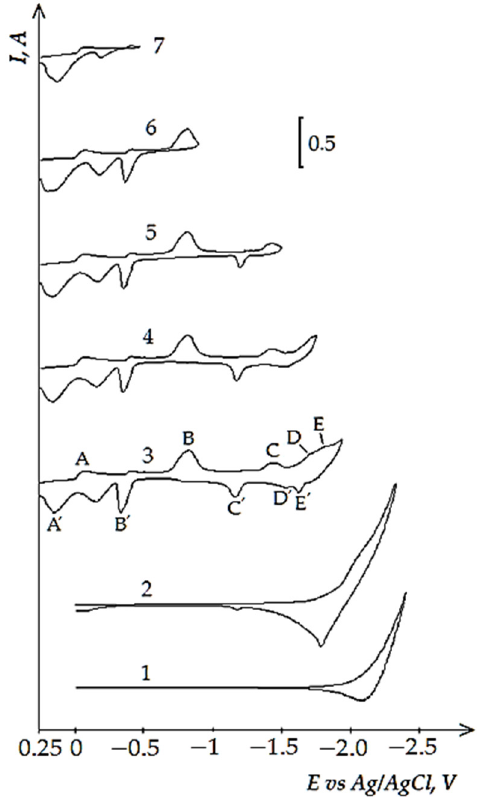
Figure 5. Cyclic voltammograms of electrochemical coeducation of Nd 3+ and Ni 2+ ions on the tungsten electrode in the equimolar KCl-NaCl melt at 973 K, polarization rate of 0.2 V/s at different reverse potentials: curves (1 and 2)—( − 2.4 V), curve 3 ( − 1.94 V), curve 4 ( − 1.75 V), curve 5 ( − 1.5 V), curve 6 ( − 0.9 V), curve 7 ( − 0.48 V). Concentrations of NdCl 3 : curve 1—0 mol/cm 3 ; curves (2–7)—4.0 × 10 − 5 mol/cm 3 . Concentrations of NiCl 2 : curves (1 and 2)—0 mol/cm 3 , curves (3–7)—1.0 × 10 − 4 mol/cm 3 . A square of the cathode is 0.4 cm 2 .